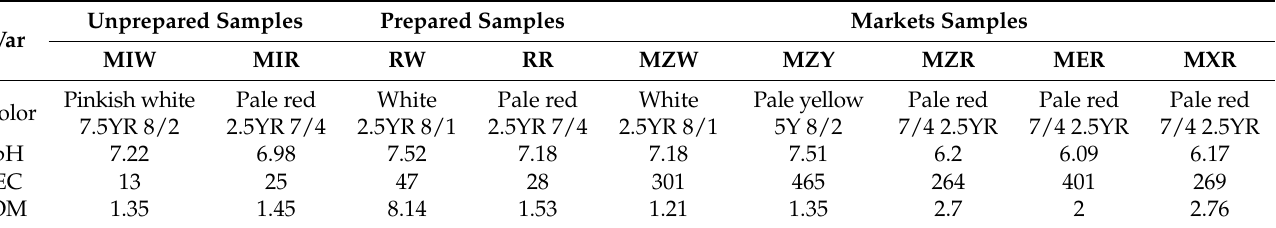
Table 1. Samples physical